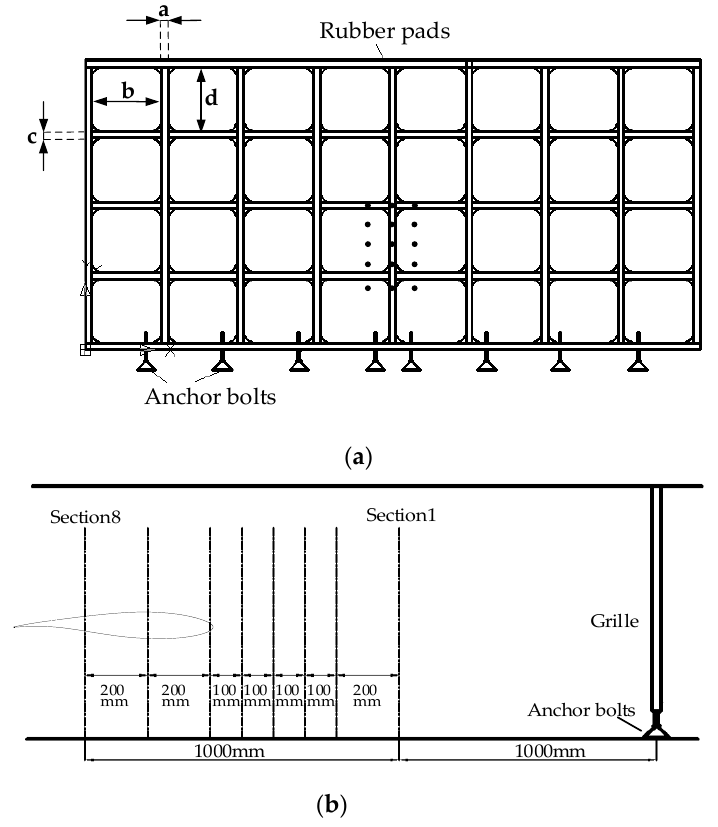
Table 1. Dimensions of the experiment grilles.